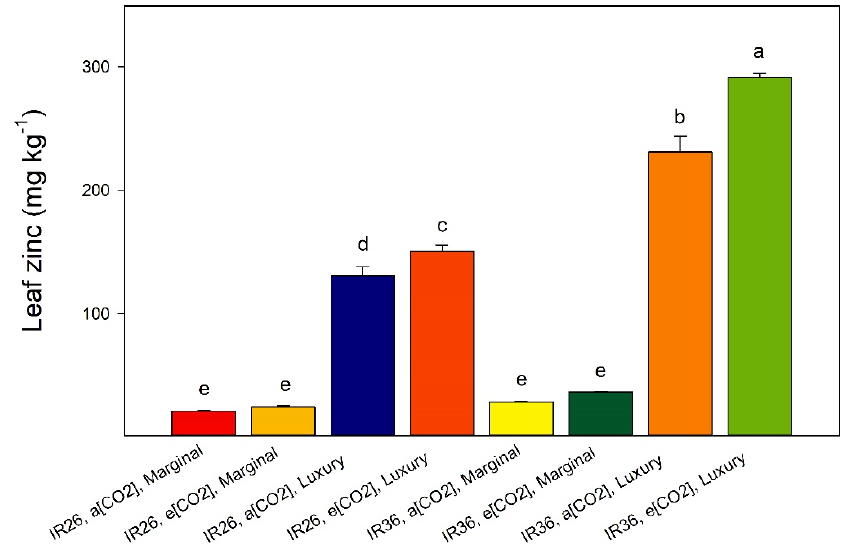
Figure 2. Foliar zinc concentration at panicle emergence. Data are means of three replicates, the bars represent standard errors, and columns headed by different letters differ significantly ( p < 0.05). For ANOVA see Table S4.